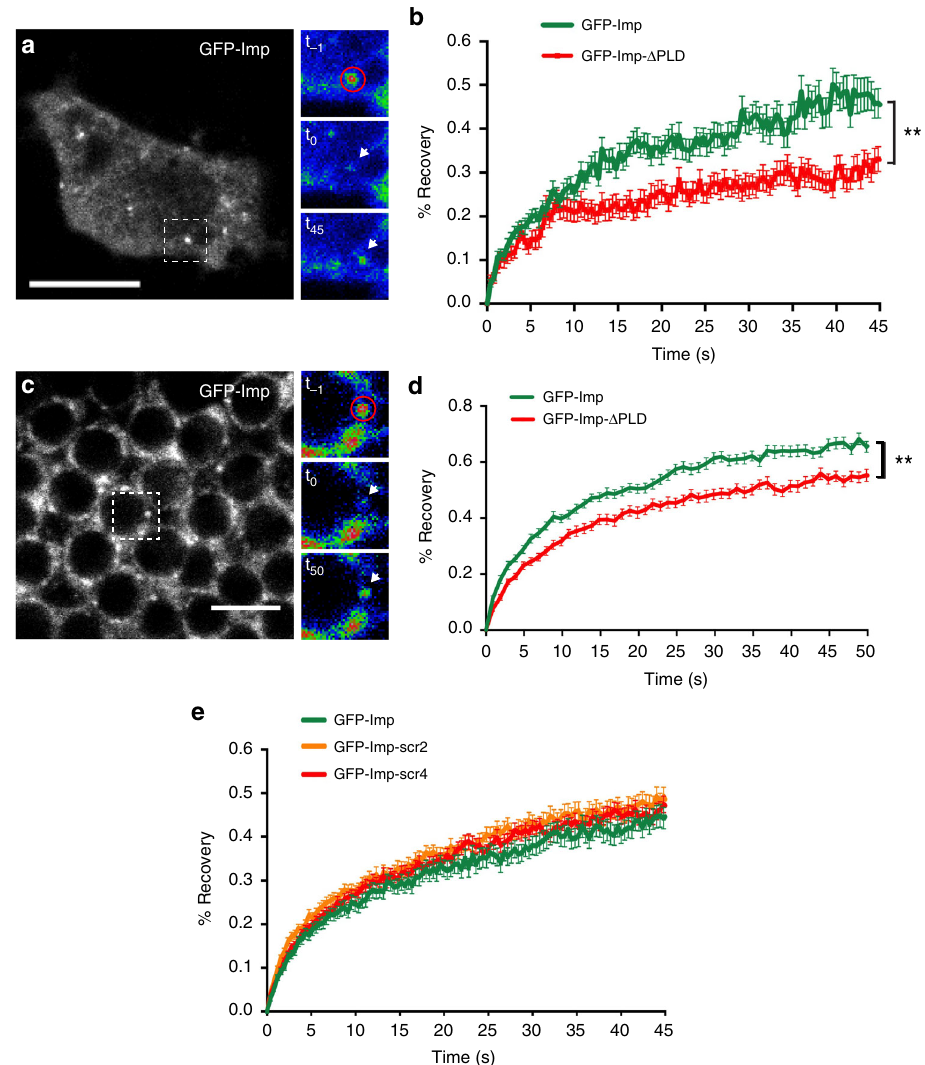
Fig. 8 Imp PLD promotes Imp granule dynamics. a S2R + cell expressing GFP-Imp. The dashed box indicates the region shown on the right. The red circle delimits the photobleached region, and the white arrows the position of the bleached granule over time. t − 1 and t 0 correspond, respectively, to pre- and post-bleaching time points. t 45 corresponds to the last recorded time point (t = 45 s). Images were color-coded using the Rainbow RGB function of ImageJ. Scale bar in a : 10 μ m. b Average FRAP curves obtained after photobleaching of GFP-positive particles from S2R + cells. The following numbers of granules were analyzed: GFP-Imp: 44; GFP-Imp- Δ PLD: 41. c Cell bodies of adult MB γ neurons homozygous for the G080-GFP-Imp protein-trap insertion (brain explant). The dashed box indicates the region shown on the right. The red circle delimits the photobleached region, and the white arrows the position of the bleached granule over time. t − 1 and t 0 correspond, respectively, to pre- and post-bleaching time points. t 50 corresponds to the last recorded time point (t = 50 s). Images were color-coded using the Rainbow RGB function of ImageJ. Scale bar in c : 5 μ m. d Average FRAP curves obtained after photobleaching of GFP-positive particles from brain explants. The following numbers of granules were analyzed: G080-GFP-Imp: 44; G080-GFP-Imp-CRISPR- Δ PLD: